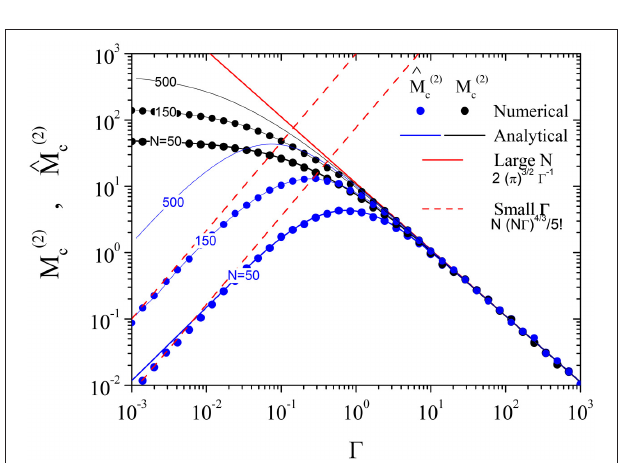
, limit reported in →∞